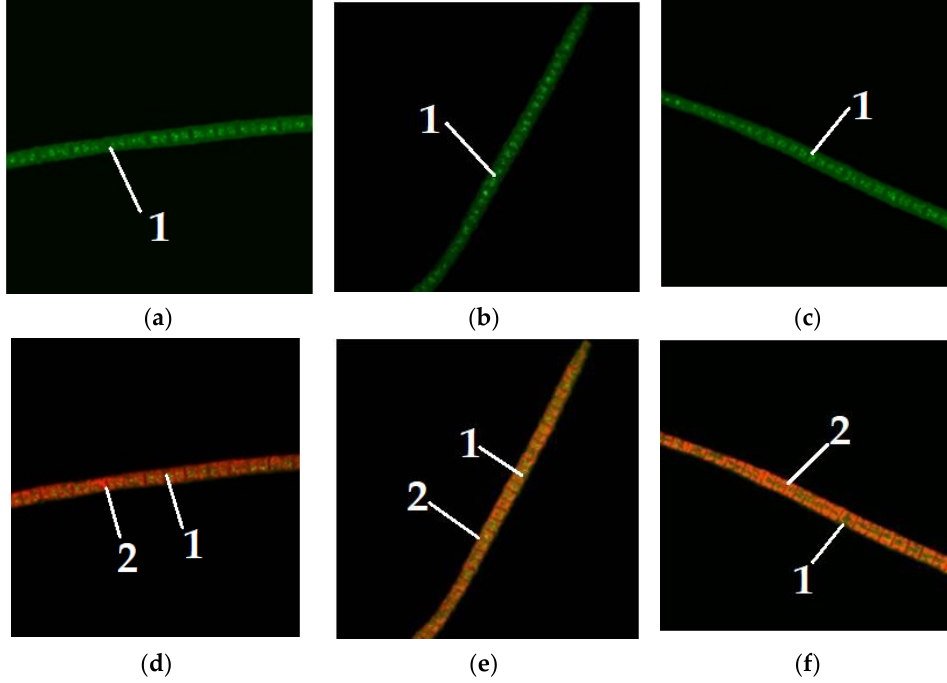
Figure 6. Microalgae Arthrospira platensis when maltose was added to the nutrient medium (1 – lipid droplet, 2 – chlorophyll): ( a – c ) visualization of lipids; ( d – f ) visualization of chlorophyll.